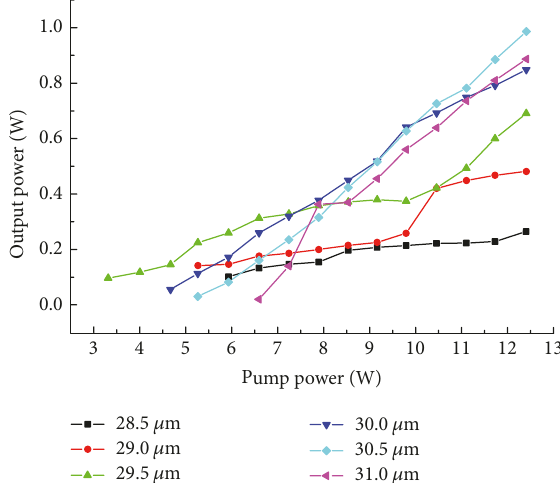
Figure 2: The tuning curves of the SR-OPO system versus the grating period of the MgO:PPLN crystal at different controlled temperature value.